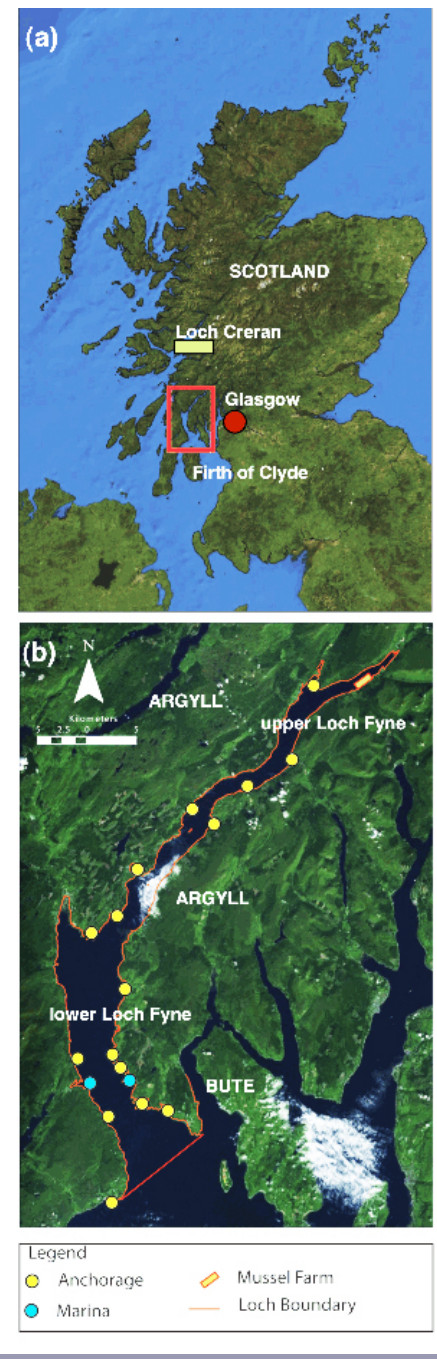
Fig. 1 . The Science-Policy Interface as conceptualized for this Systems Approach Framework (SAF) application (Tett and Sandberg 2011). Institutions are shown as sharp- cornered rectangles, groups of actors as round-cornered rectangles. 'Knowledge', 'decision' and 'deliberation' refer to the characterizing features, for present purposes, of each group of actors. Three levels of governance (constitutional,